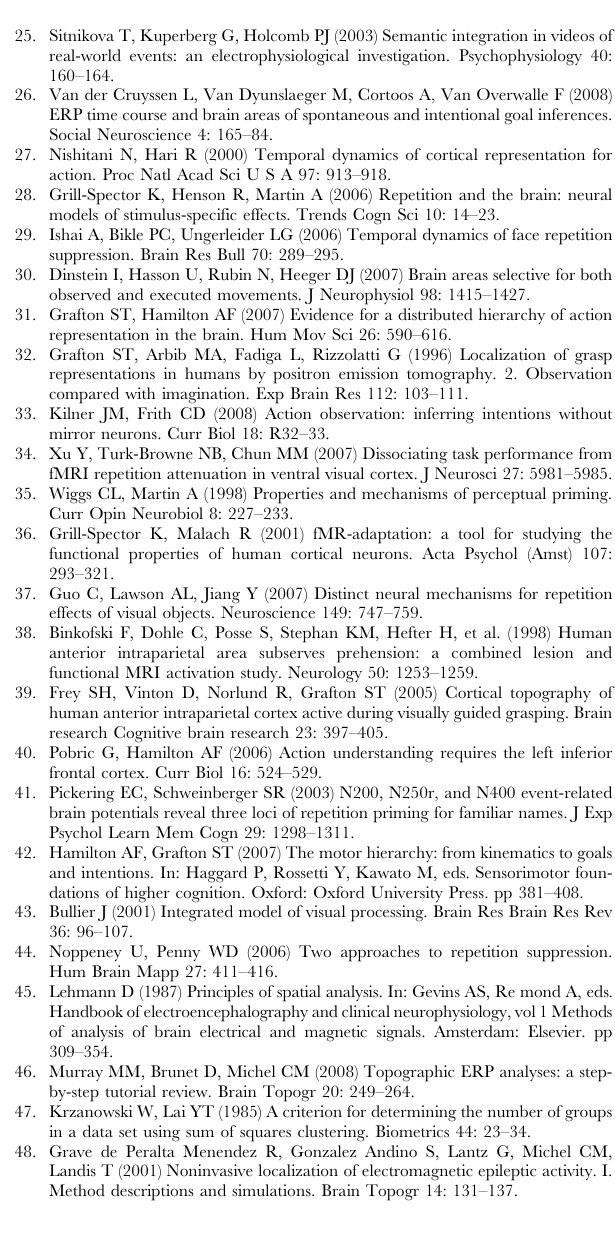
Table S3 Local maxima (in Talairach coordinates) of periods of brain stability (i.e., microstates) are provided in the table. Asterisk indicates the time period that is significantly present in the novel object condition in comparison with the repeated object condition. P , 0.05.